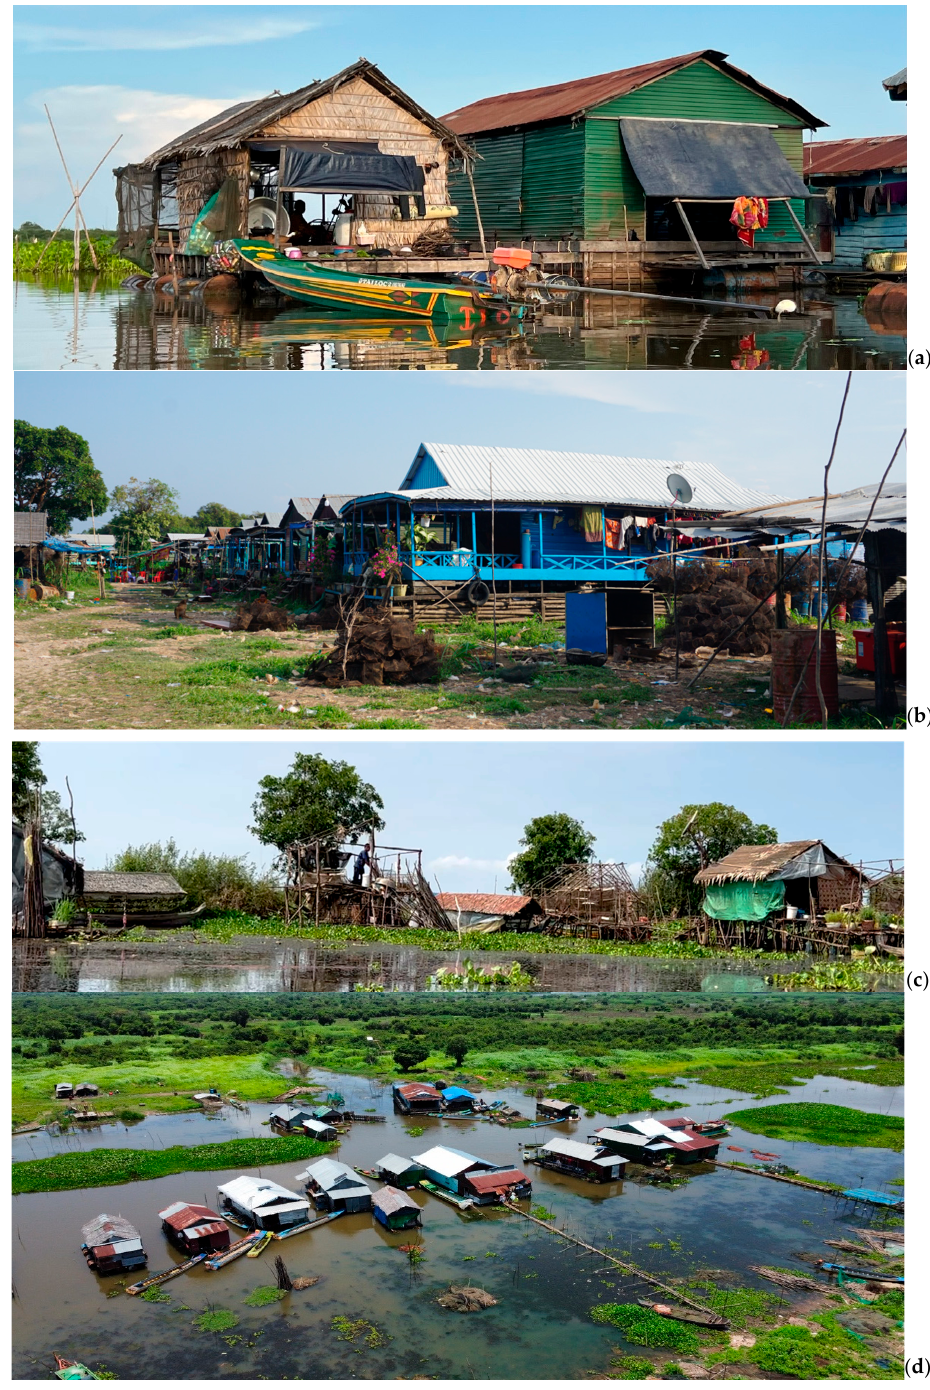
Figure 9. Amphibian housing and seasonal (re)construction. The ‘amphibian’ settlement dramatically changes with the seasons. The traditional boat houses and bamboo − framed houses have frames that support the floating component, usually a bamboo raft and/or platform with metal barrels. The house structure can stand on land or at the water’s edge in the dry season. The house and floating parts are reassembled and repaired every dry season: ( a ) floating houses in Daun Sdeung village; ( b ) floating houses stand on dry land adjusted to the shallow river in Peam Bang village, ( c ) Stage of reconstruction in Pichakrei village; ( d ) a house cluster responding to small gradients of wetness and inundated topography in Pichakrei village (Linh Vu, April 2022).